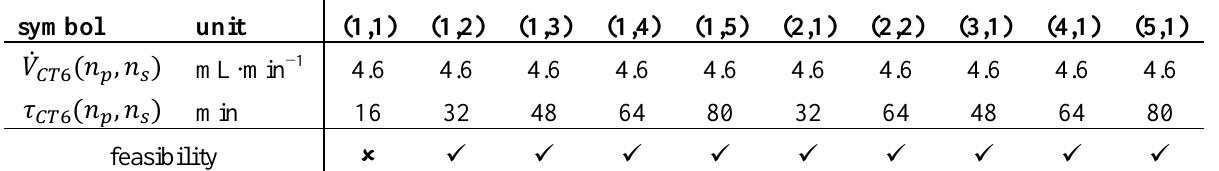
Table 4. Results for CT6 after residence time criterion.